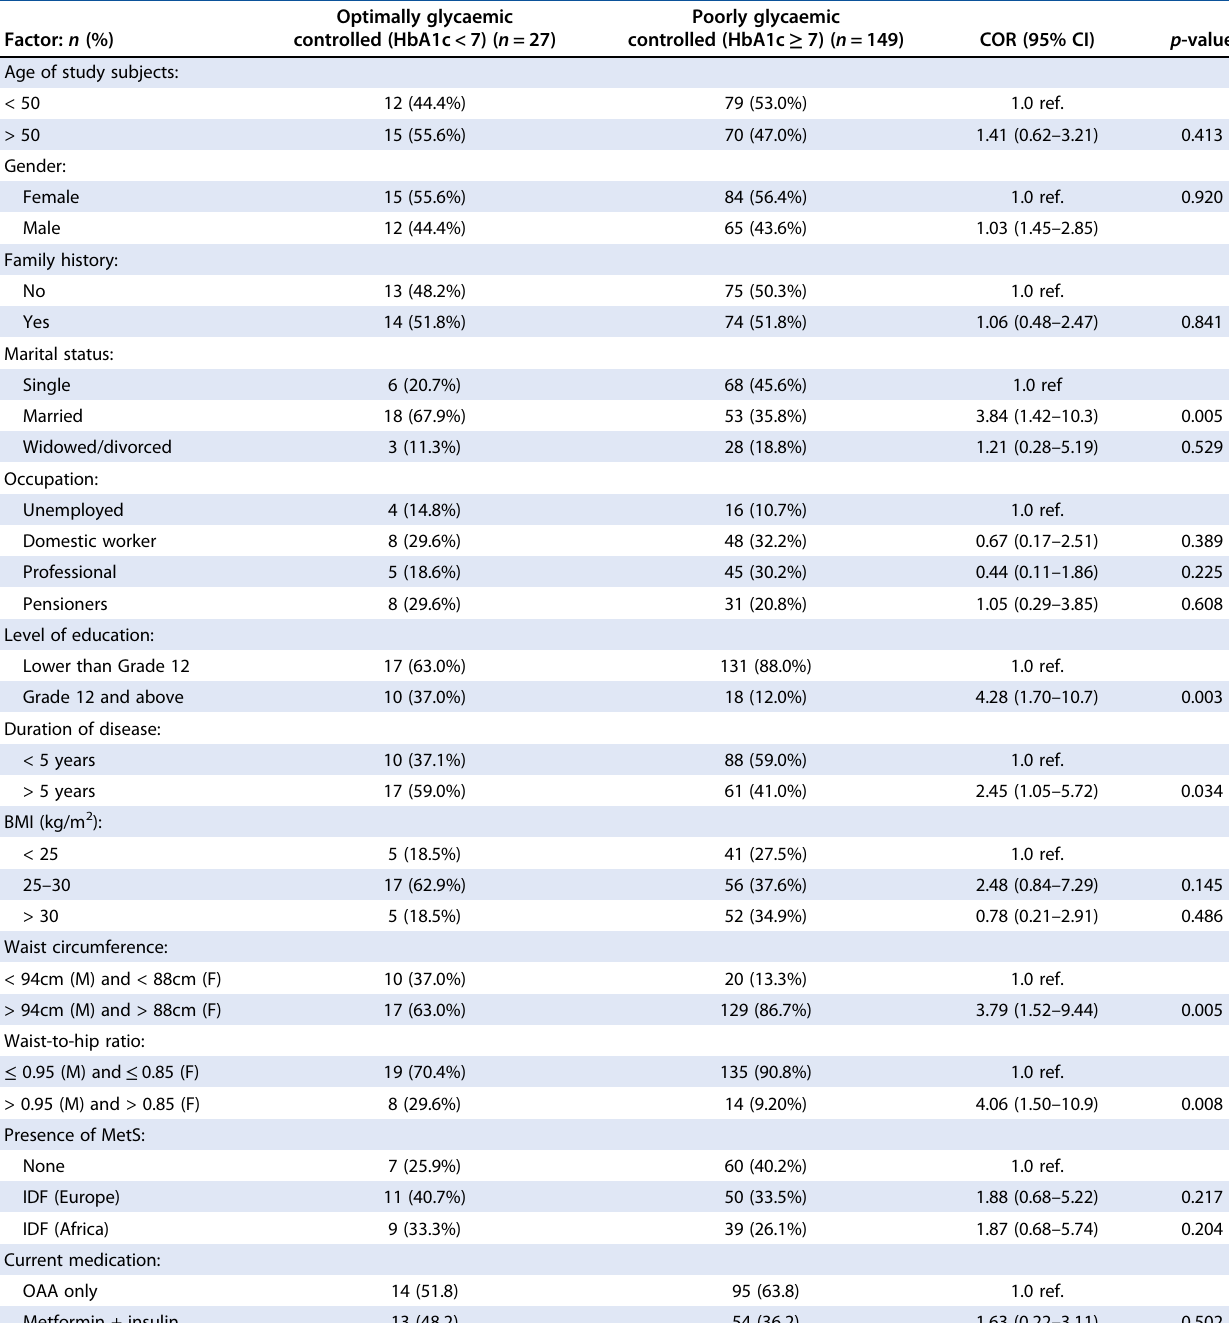
Table 4: Bivariate logistic regression analysis of the association between known determinants of poor glycaemic control and poor glycaemic control at DGMAH